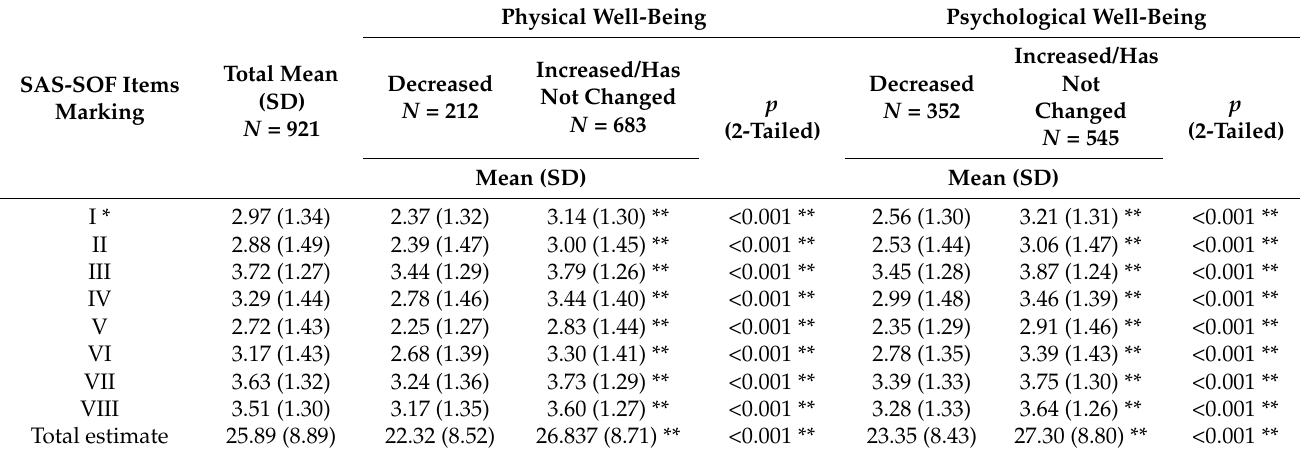
Table 3. Characteristics of SAS-SOF indicators and comparison by groups of change of physical and psychological well-being.